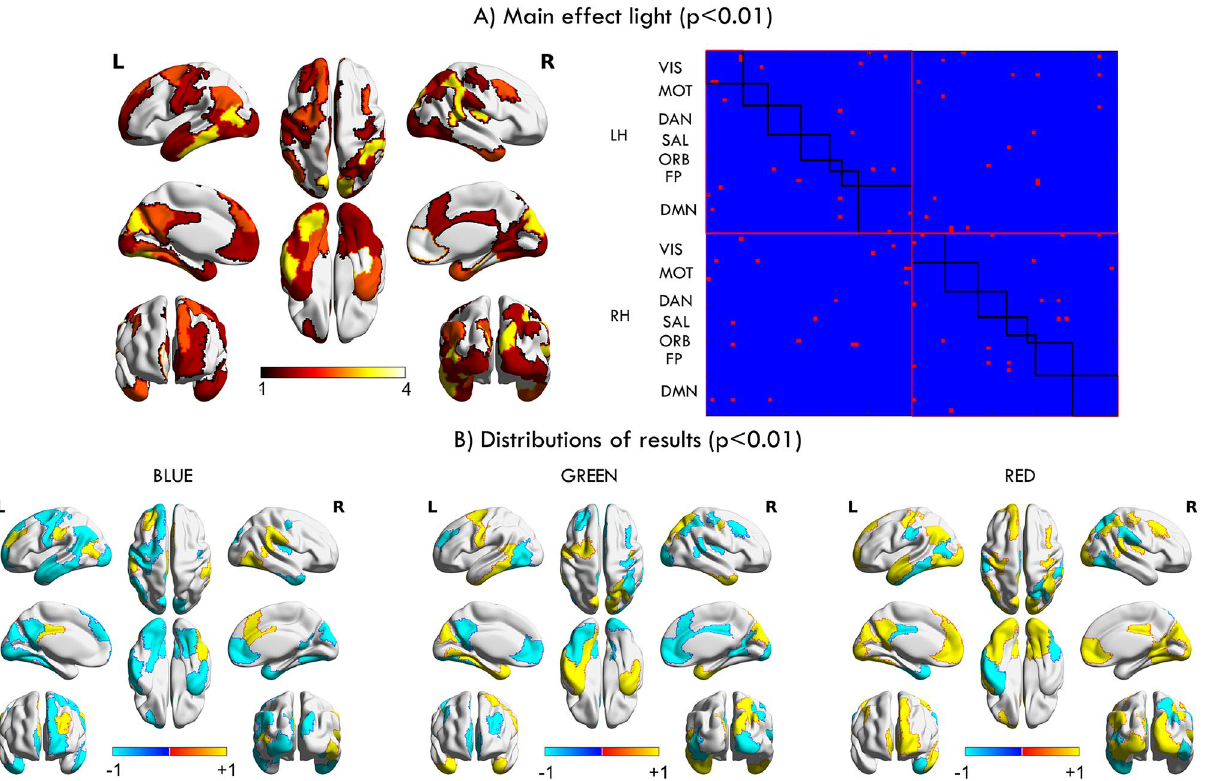
Figure 2. Projections that were significant at uncorrected p value < 0.01 into the brain surface. In panel ( A ) on the left is shown the projection onto the brain of the main effect of light. To note that any given ROI can have a maximum of 99 significant connections with the rest of the ROIs. This can be observed on the right side of panel ( A ), where each row (and column) in the symmetrical binary matrix corresponds to a ROI, and a red square inside of the matrix represents a significant connection (each connection involves two ROIs). Therefore, adding together the values across the rows yielded a value for each ROI indicating the most sensitive areas after light exposure which is projected onto the brain surface in the left side of panel A. The heat map illustrates all the areas sensitive to light exposure, being the yellowish the most sensitive and the red-dark the less. The colorbar illustrates the number of times that appeared in the left matrix. In panel ( B ), are the brain projections associated with each kind of light exposure, after that for the connections described in panel A) we assessed the highest/lowest value and their correspondence to the type of light exposure. In panel ( B ), hot colors indicate the values where the ROIs are increasing the FC, while blue colors indicate the opposite. Abbreviations: LH: Left hemisphere, RH: Right hemisphere, VIS: visual network, ASM: auditory and somatosensory network, DAN: the dorsal attention network, SAL: saliency network, ORB: orbitofrontal-temporopolar network, FP: frontoparietal, DMN: default mode Those connections with p < 0.01 were projected into the brain. Figure 2 in panel A are shown the significant connections and their projection into the brain. It is important to note that each connection involves two ROIs, and therefore one region can be present more than once and this is captured by the heat map. Particularly, we observe that MPFC, visual areas and ventral medial temporal areas exhibit a higher main effect of light. At net- work level, we observed the DMN mainly in the left hemisphere and the VIS in both hemispheres. Also, some areas involve other networks such as the FEF corresponding to the DAN, the ventral medial temporal areas corresponding to the ORB, and the right inferior parietal corresponding to the SAL network. For each one of these connections, we examined under which of the three stimulation conditions the connec- tion was the highest or the lowest. Projections into the brain surface of this computation are shown in Fig. 2 panel B). Compared with the other two, blue light stimulation indicated a general decrease of FC in these significant areas, except in those areas associated with the salience network such as the anterior cingulate cortex and the supramarginal gyrus (F = 7.91, P = 0.007). Particularly, within the VIS regions (F = 12.77, P = 0.001), in several regions of the DMN such as the left parietal with the temporal pole (F = 15.47, P < 0.001), and in the left PFC with the temporal pole (F = 9.24, P = 0.004), showed a decreased FC in comparison with the other two groups. The green light exposure compared with the other two light exposures indicated a decrement in the FC integ- rity in the DMN particularly evident in the midline, as seen in connections between the PPC and the somato- motor areas (F = 7.97, P = 0.007) and between the PFC and visual regions (F = 11.7, P = 0.001), however, in the lateral DMN there was a clear FC increment, for example between the parietal DMN regions and the temporal pole (F = 15.47, P < 0.001). Also, other regions belonging to the SAL network experienced a higher FC such as the superior parietal cortex with the DLPFC (F = 7.43, P = 0.009) and portions of the supramarginal gyrus with